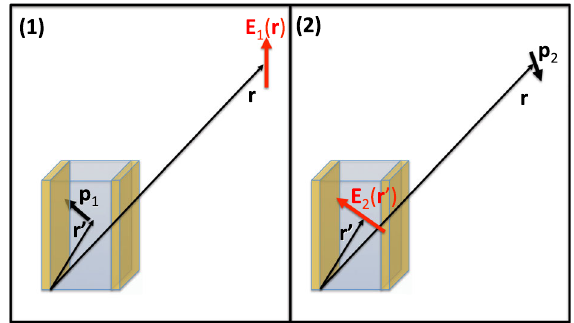
FIG. 1. Illustration of two reciprocal situations (1) and (2) ob- tained upon exchanging source and detector positions. The cavity is an example of an optical system made of reciprocal